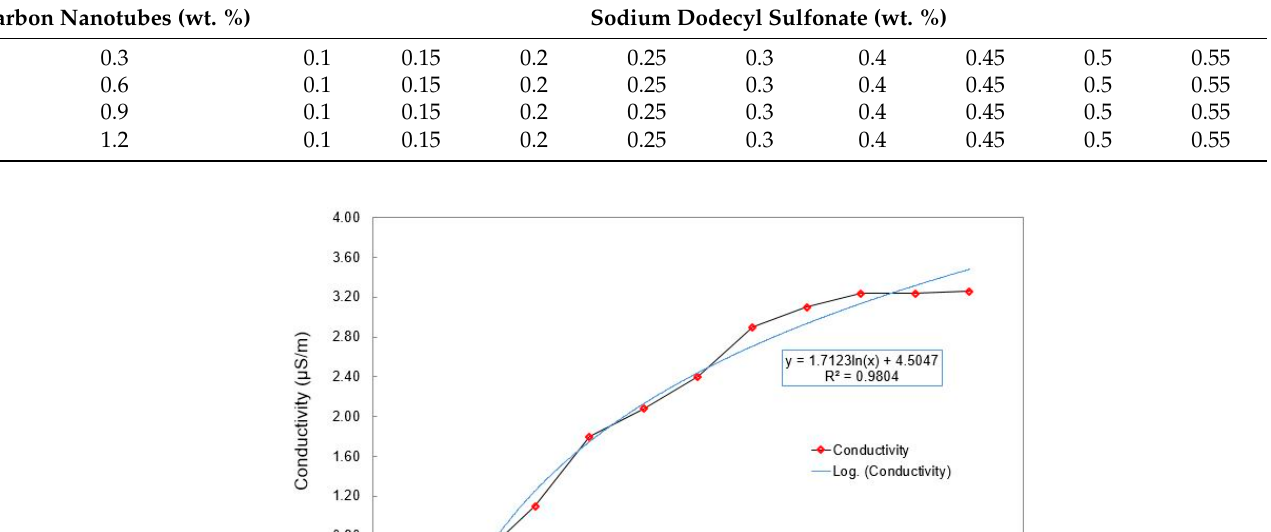
Table 1. Amount of CNTs and SDS mixed in the nanocomposites.